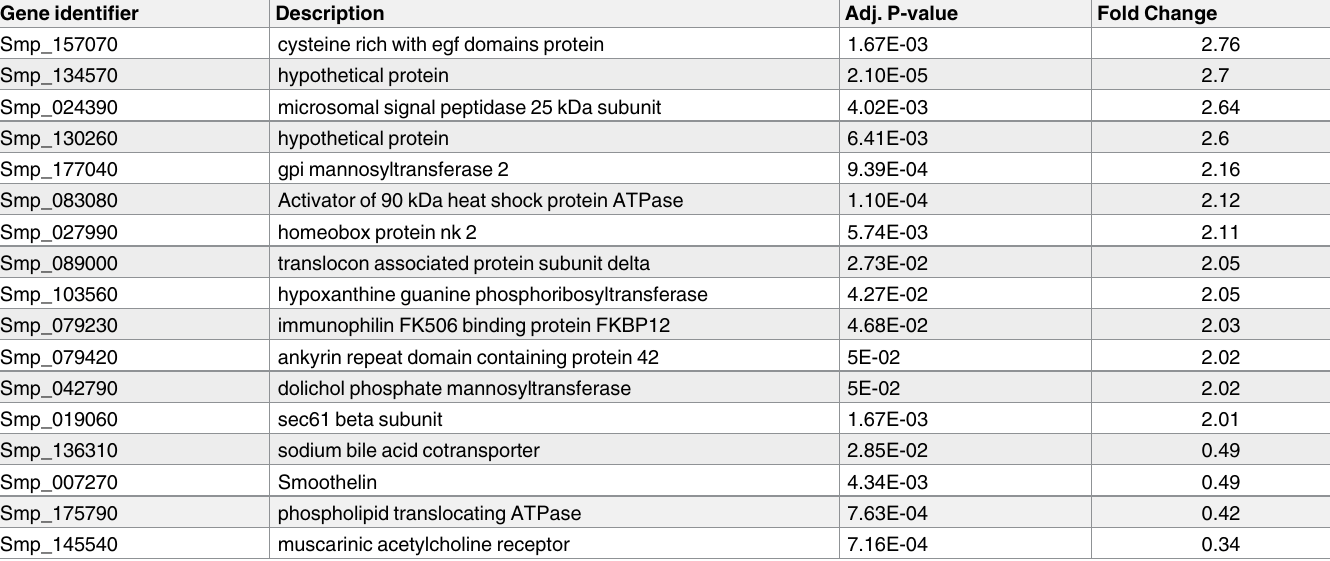
Table 2. Subset of genes differentially expressedin schistosomula cultured of 12hours in portal serum by RNASeq. Gene